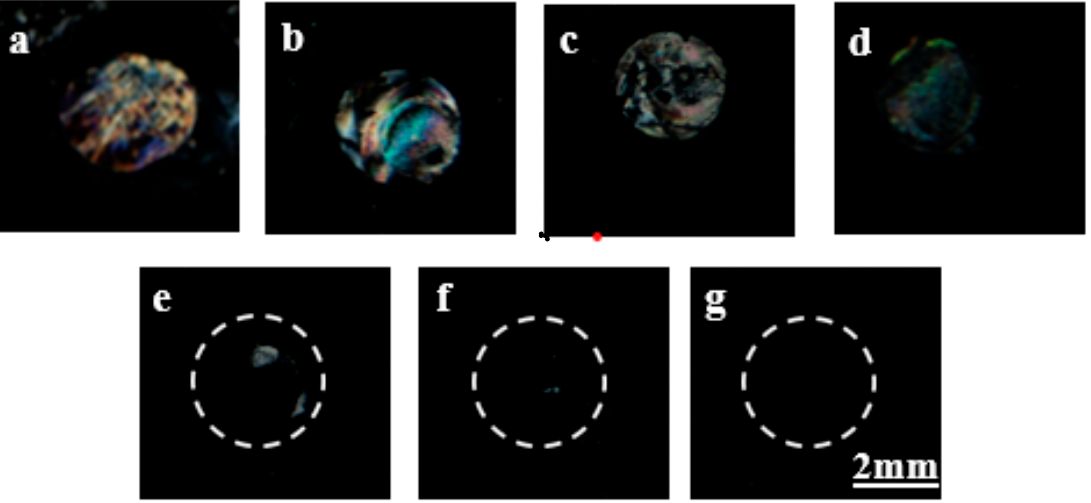
Figure 5. Polarized optical images of LCs supported on DMOAP-coated glass slide printed by AuNPs–PDMS stamp with immobilized probe (B40t77 aptamer) incubated with ( a ) 8 ( µ g/mL), ( b ) 6 ( µ g/mL), ( c ) 4 ( µ g/mL), ( d ) (2 µ g/mL), ( e ) 1 ( µ g/mL), ( f ) 0.5 ( µ g/mL) and ( g ) (0 µ g/mL) of target protein gp-120.